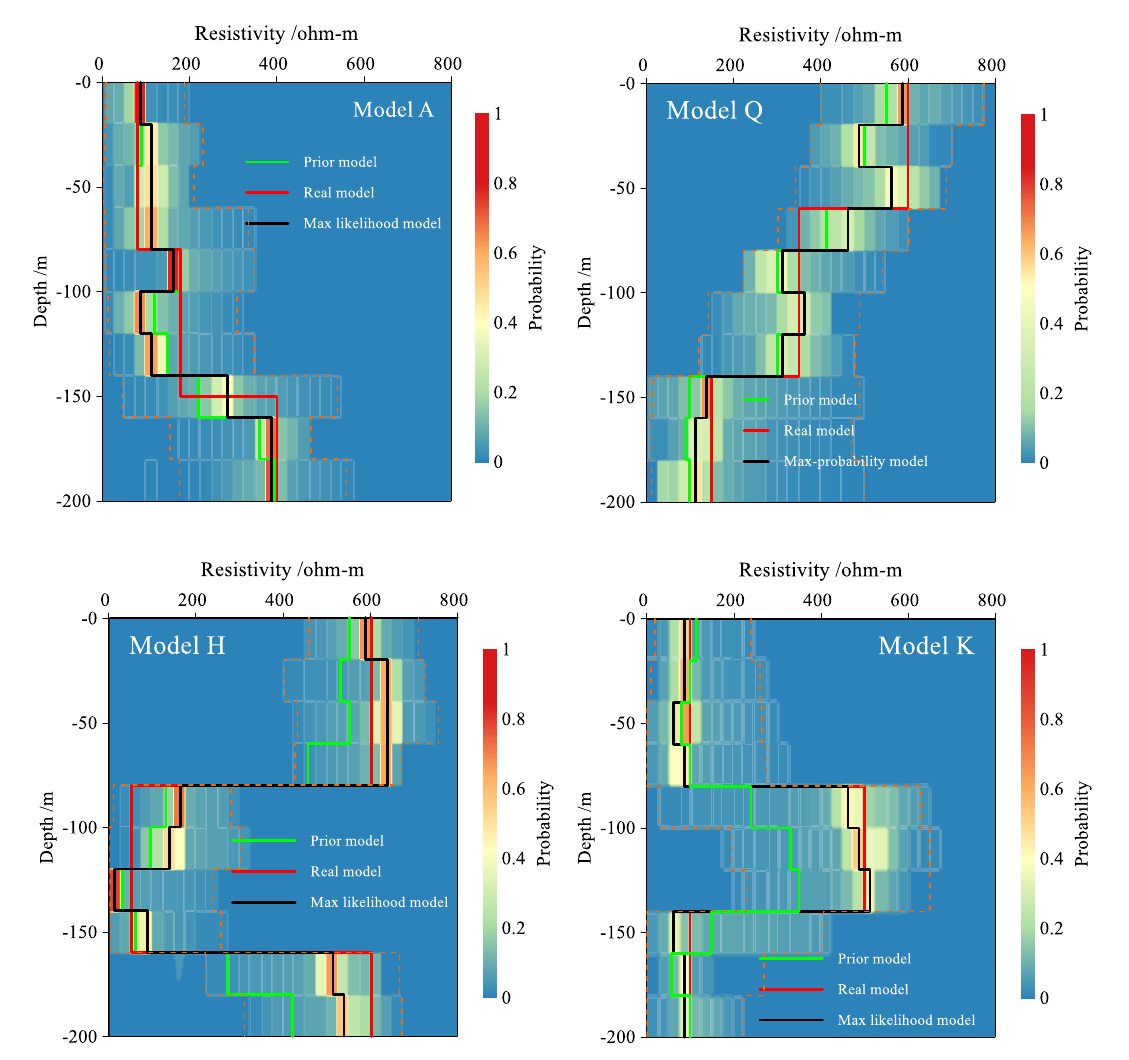
depth. Also shown are the prior models inferred from least-squares inversion (green lines). Maximum probability models (black lines) and the real models used to generate the underlying synthetic TEM data (red lines). The orange dotted lines are the 5% and 95% confi- dence boundary of the posterior distribution in each